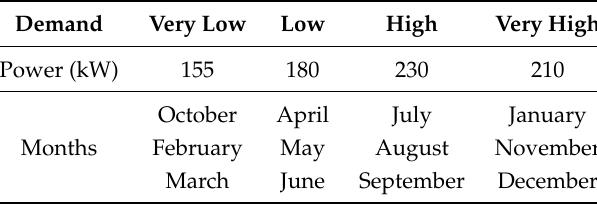
Table 1. Monthly power dependence to national grid supply.